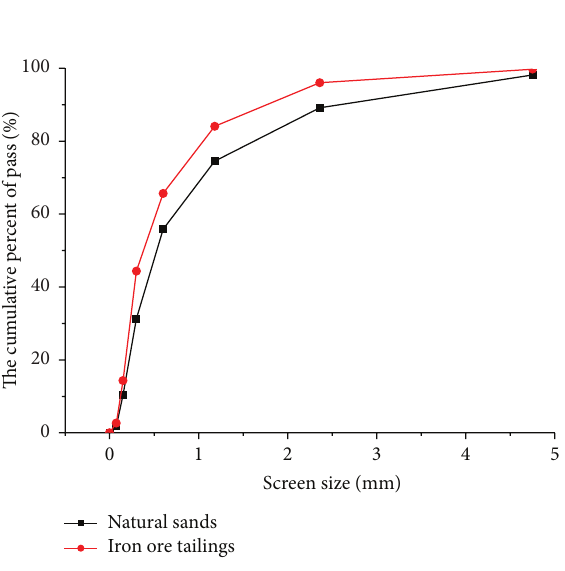
Figure 1: XRD of IOT. Figure 2: Grading curve of